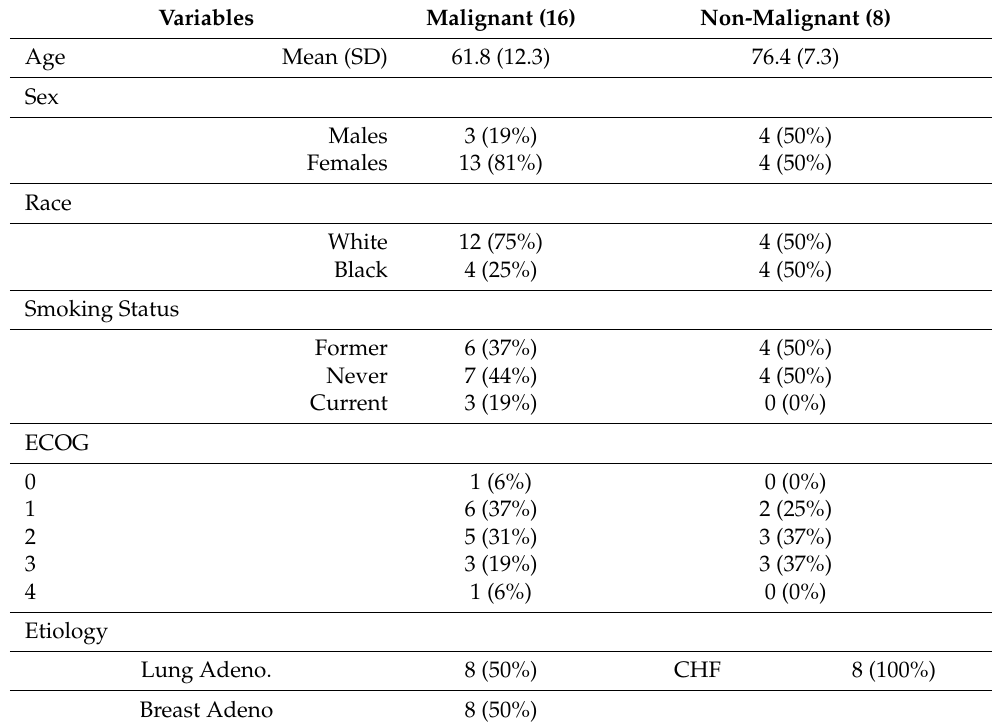
Table 1. Patients’